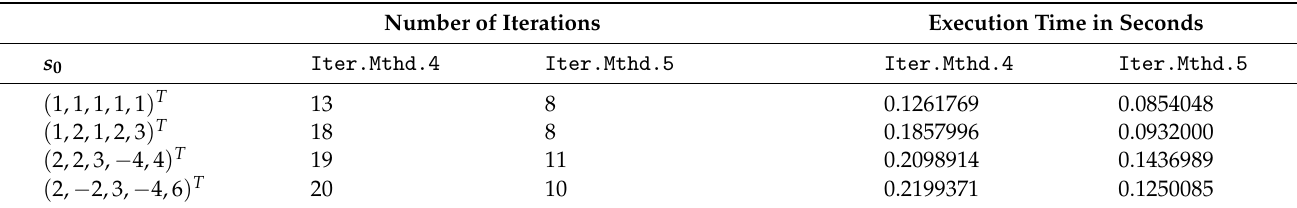
Table 2. The proposed two techniques have numerical data for Figures 1–8 by using Example